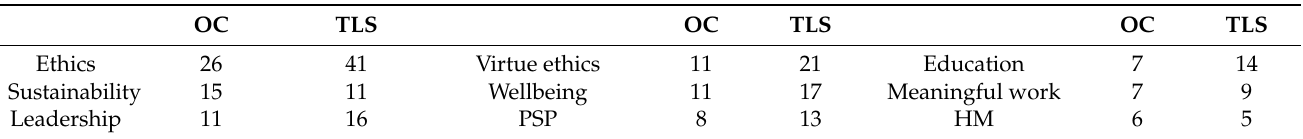
Table 8. HF: Co-occurrences and total link strength of business-related selected keywords (SCOPUS database).